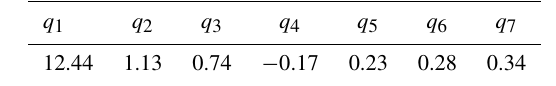
Table 5. IEA 15MW blade mean modal amplitude results for last 50s of the